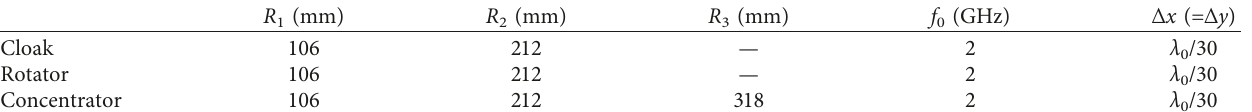
Table 3: FDTD simulation conditions.